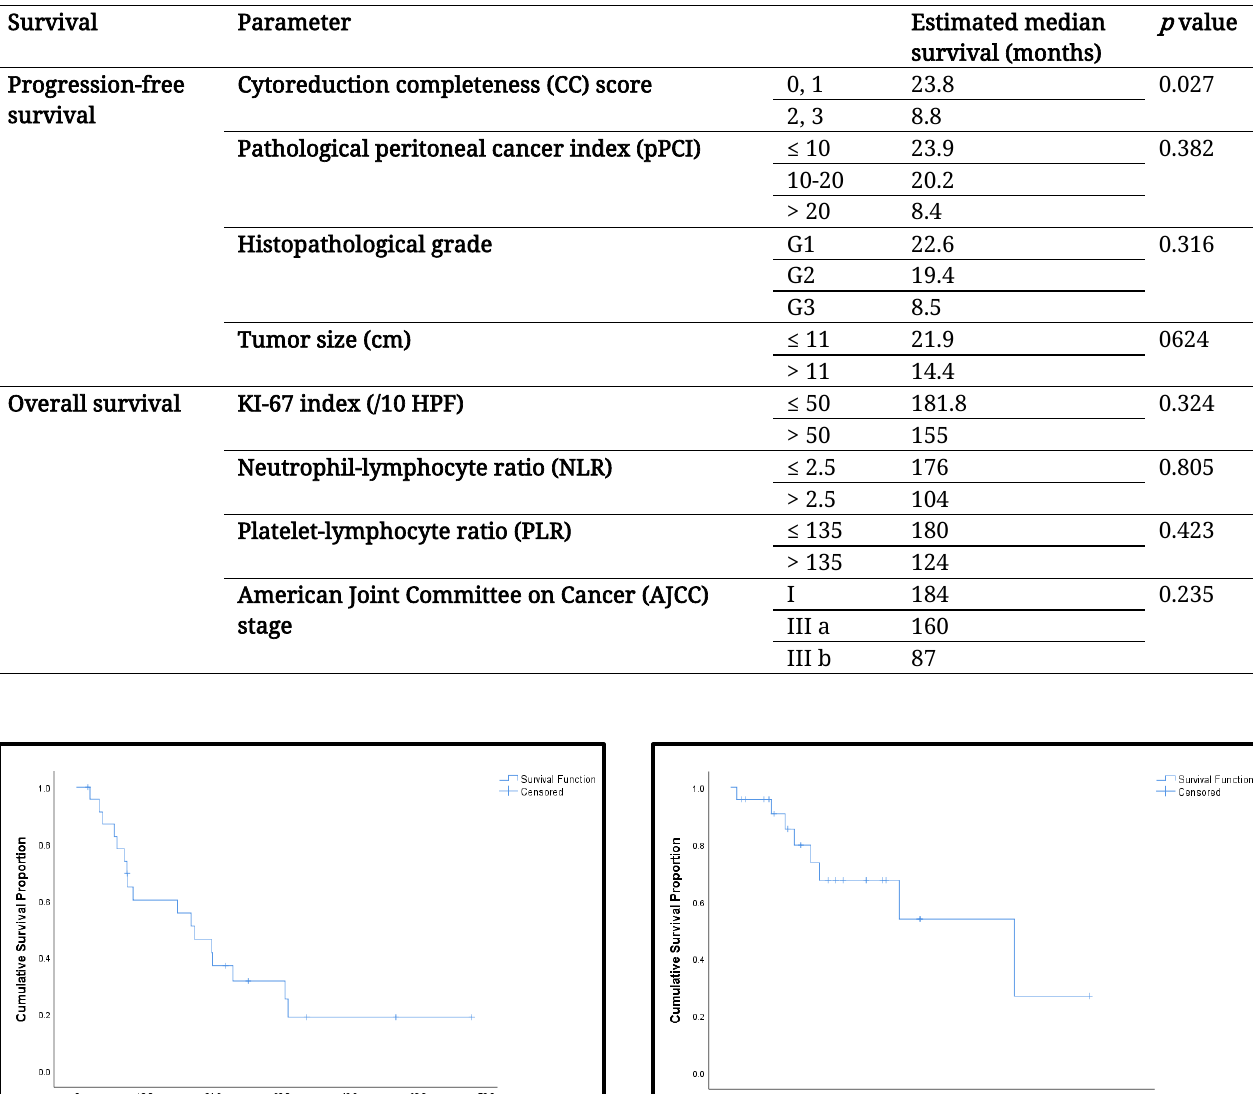
Table 5: univariate analysis correlation of multiple parameters with progression-free and overall survival